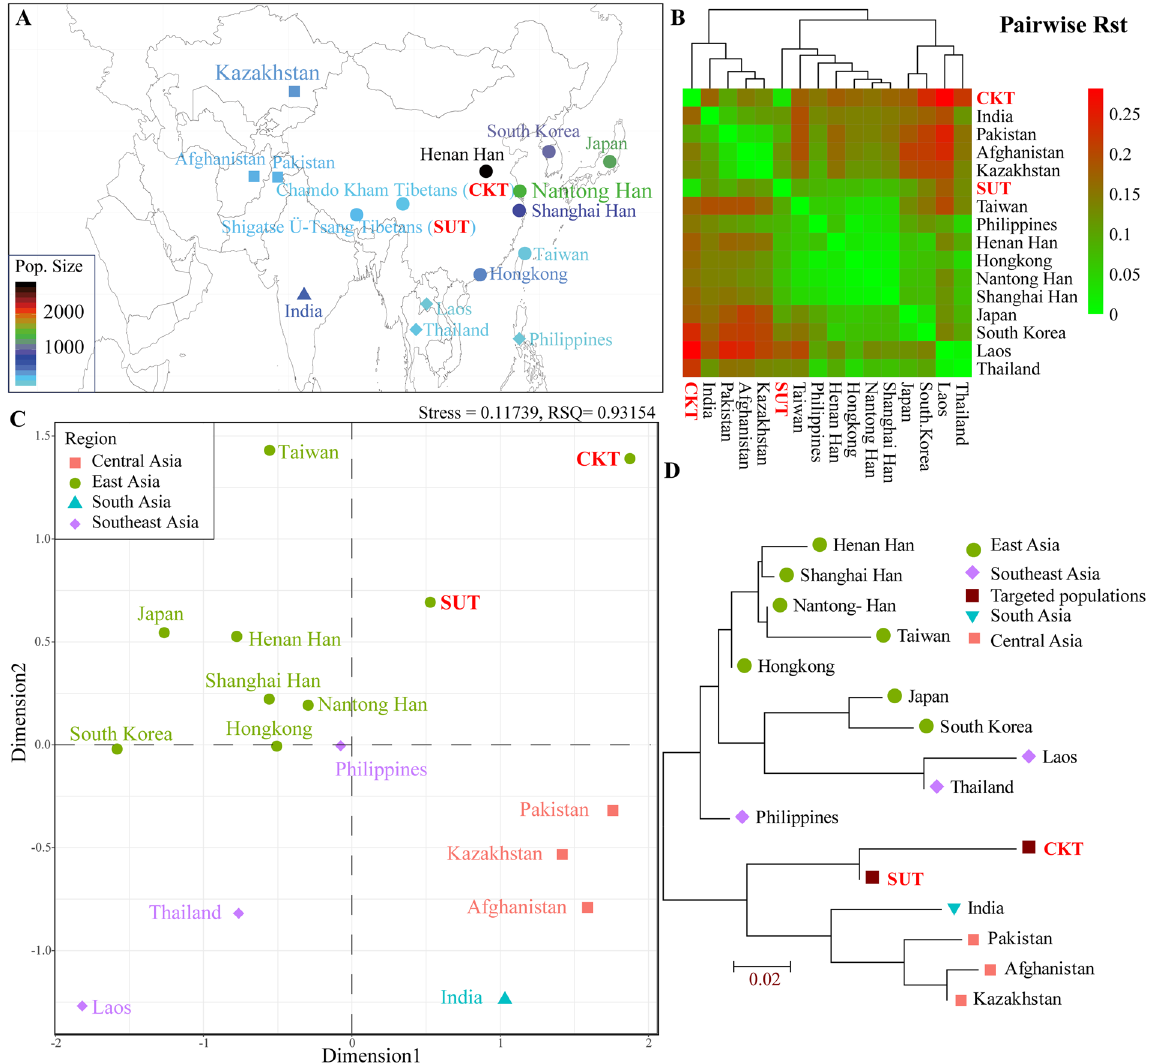
Figure 4. Genetic affinity among 16 Asian populations. ( A ) The map shows the geographic location and population size of the 16 Asian populations. The map was generated by free software R 3.3.2 (https://www.R-project.org/) 49 using the ggrepel, ggplot2, maps and mapdata packages and then modified using Adobe Illustrator CS6 software. The R script is submitted in Supplementary Note 1. ( B ) The heatmap shows the pairwise genetic distance among 16 included populations. ( C ) Multidimensional scaling plots show the genetic similarities among Asian populations. ( D ) The phylogenetic tree shows the relationship among 16